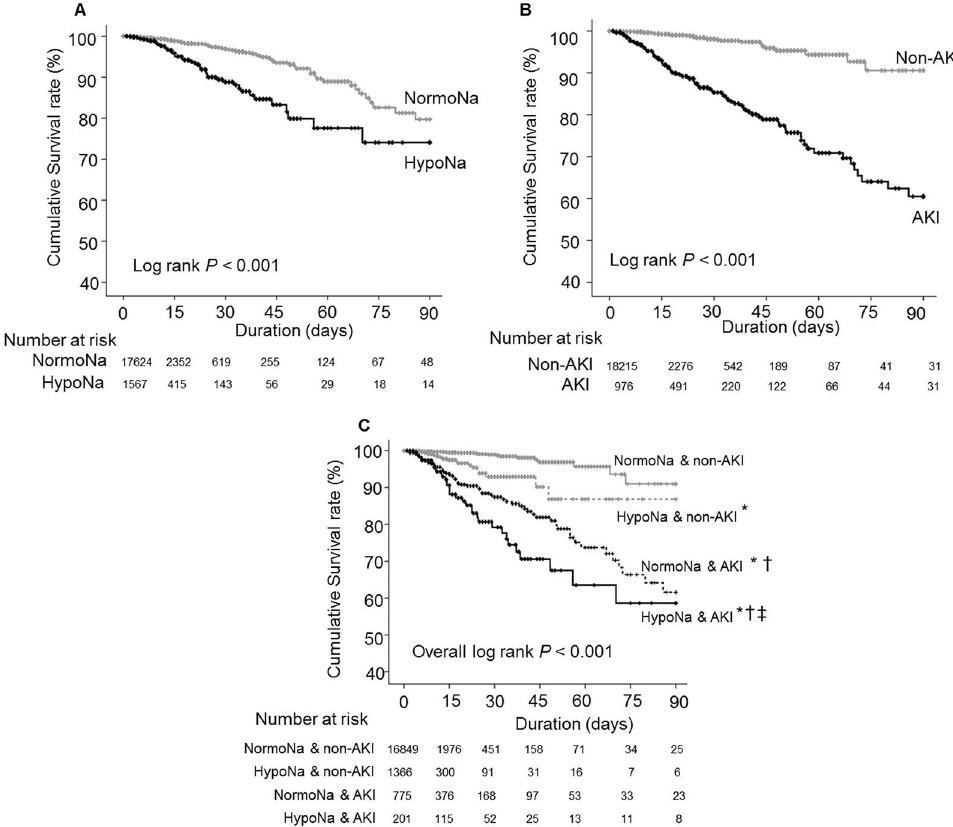
Fig 3. Cumulativesurvivalrate according to sodium(Na)and acutekidney injury(AKI)groups. A, B and C show survival curves of sodium, AKI and combinedsodiumand AKI groups for the in-hospitalmortality, respectively. * and † indicate P < 0.001 when comparedto normonatremic patientswithoutAKI and hyponatremicpatientswithoutAKI groups, respectively, and ‡ indicates P < 0.05 when comparedto normonatremicwith AKI group using